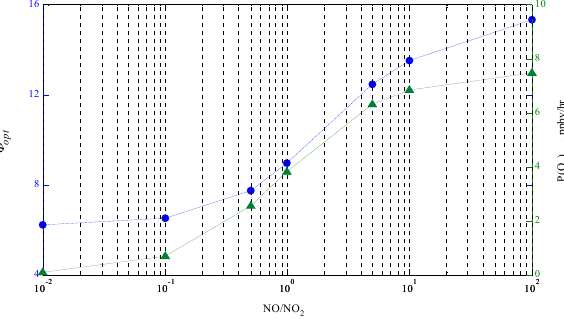
Fig. 9. Dependence of Φ opt (blue circle) and P (O 3 ) max (green triangle) on different NO/NO 2 ratio.